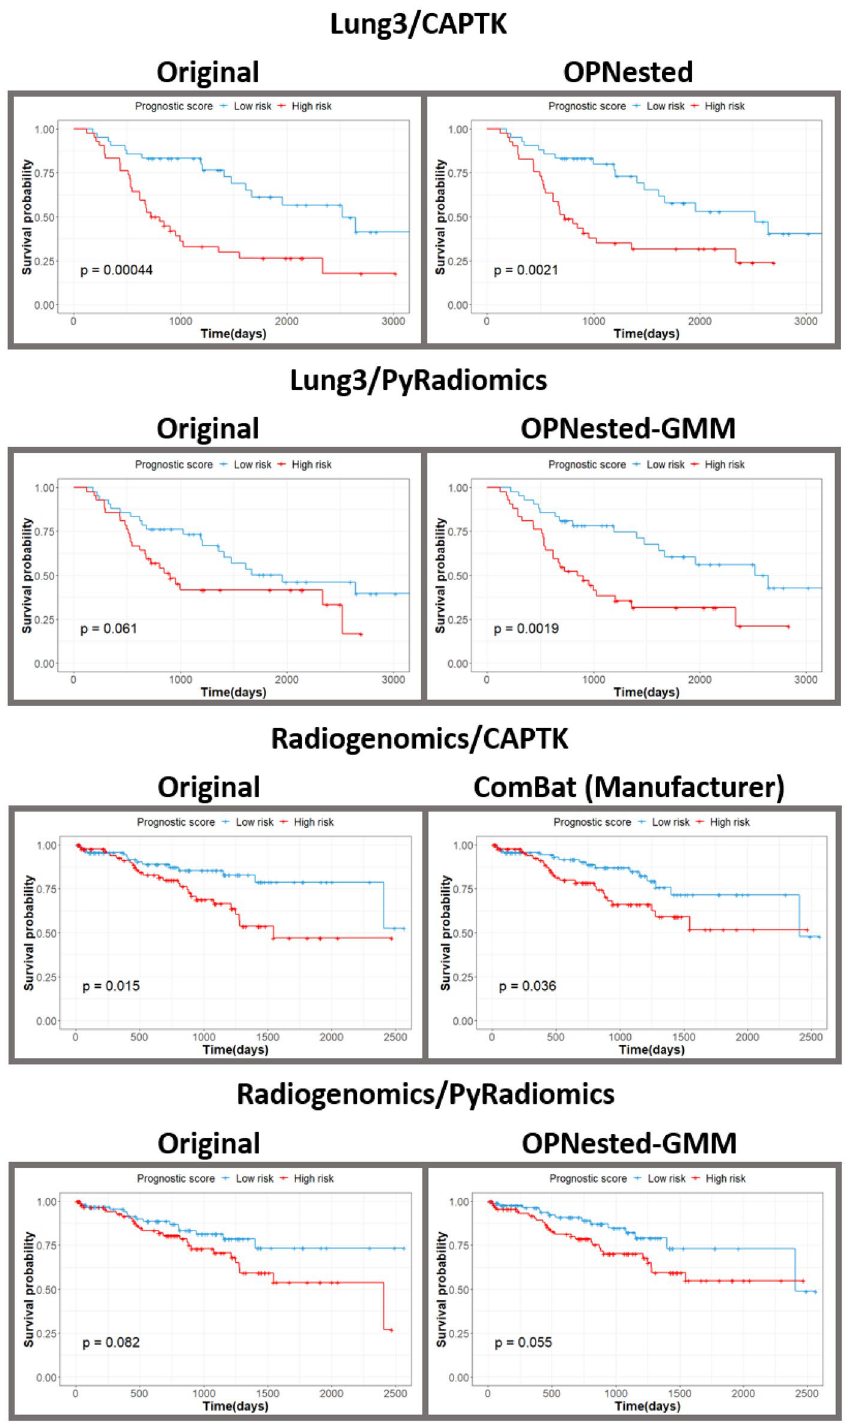
Figure 2. In-sample Kaplan–Meier curves fitted on the original features and the harmonization approach with the highest